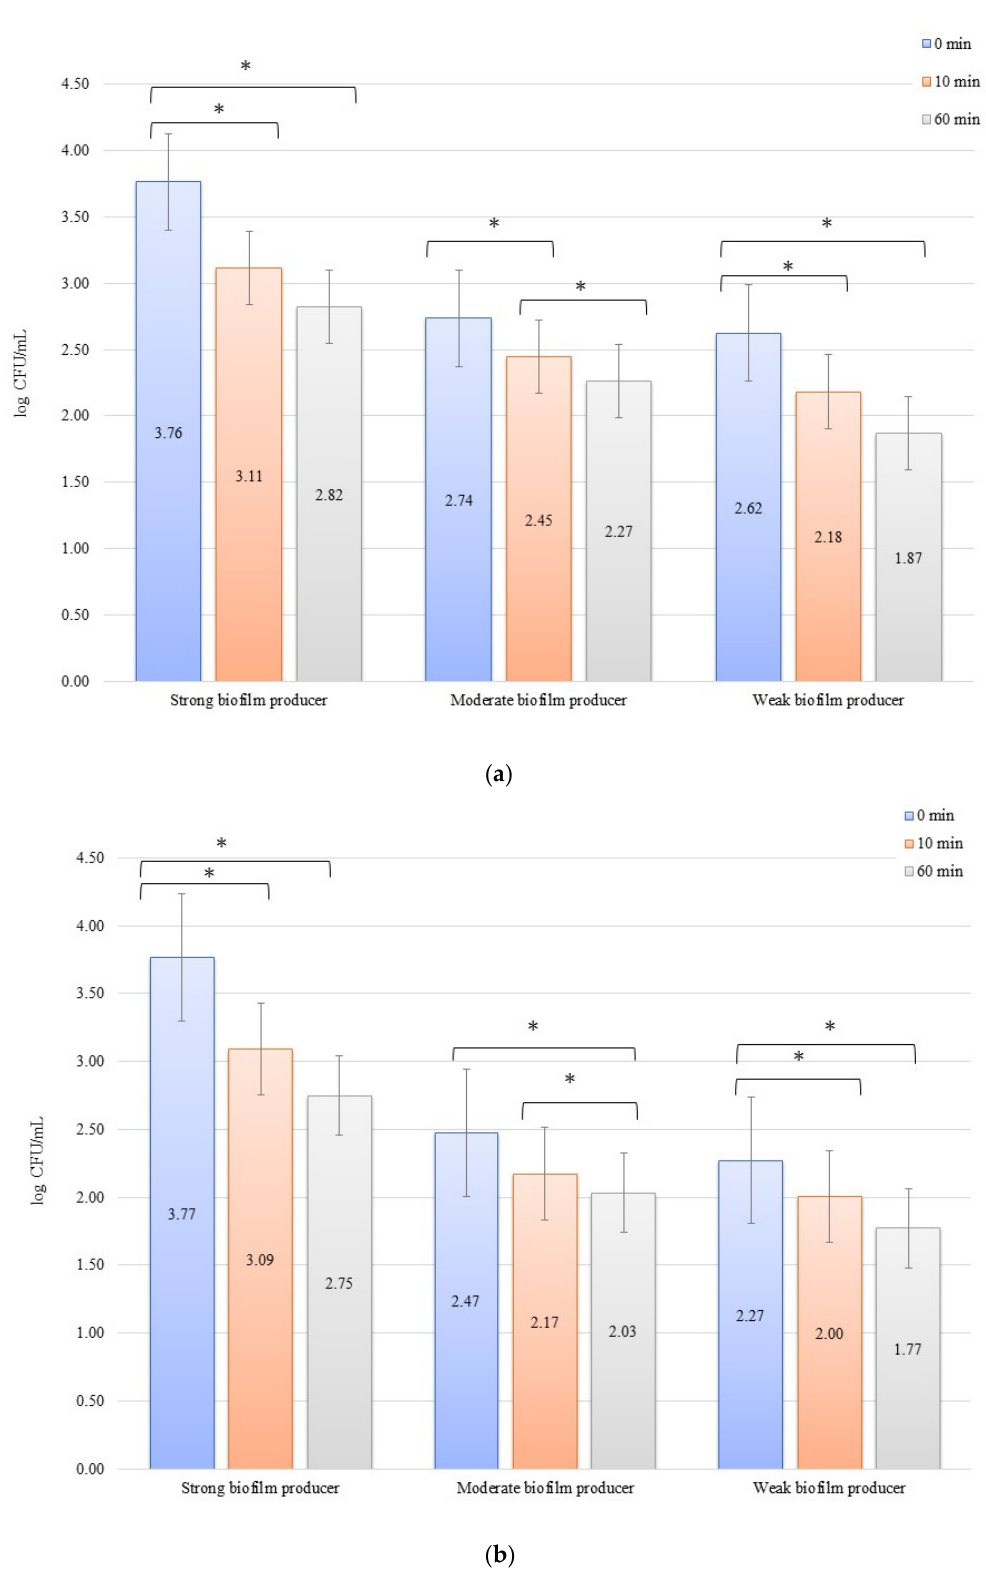
Figure 1. Biofilm eradication assay for Staphylococcus aureus . Strains forming biofilms on Ti-6Al-4V ( a ) and zirconium dioxide ( b ) discs classified as strong, moderate, and weak are treated with low direct electric current of 10 mA. Error bars represent the pooled standard deviations of the mean. The level of significance is presented at * p < 0.05. The mean and standard deviations are shown.